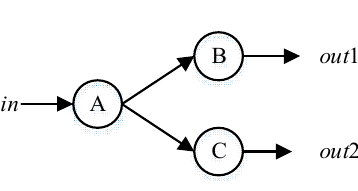
Figure 7. Structure of a Simple System.